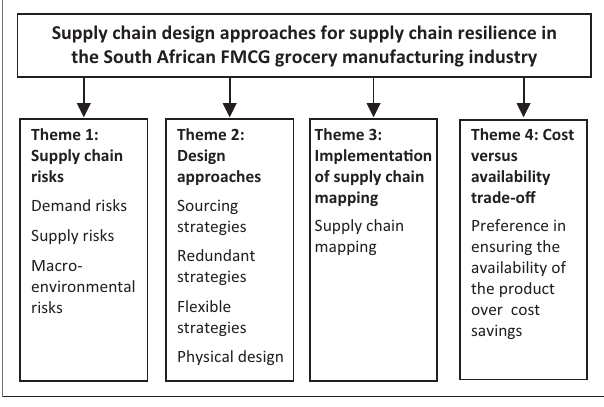
FIGURE 1: Summary of themes and